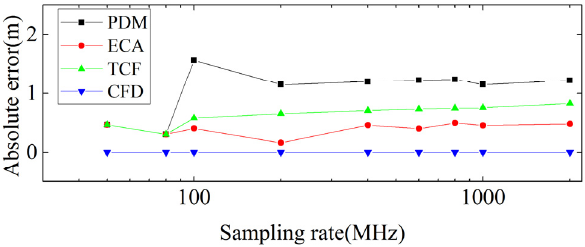
Figure 9. The absolute error values for various sampling rates of the PD pulse waveform.